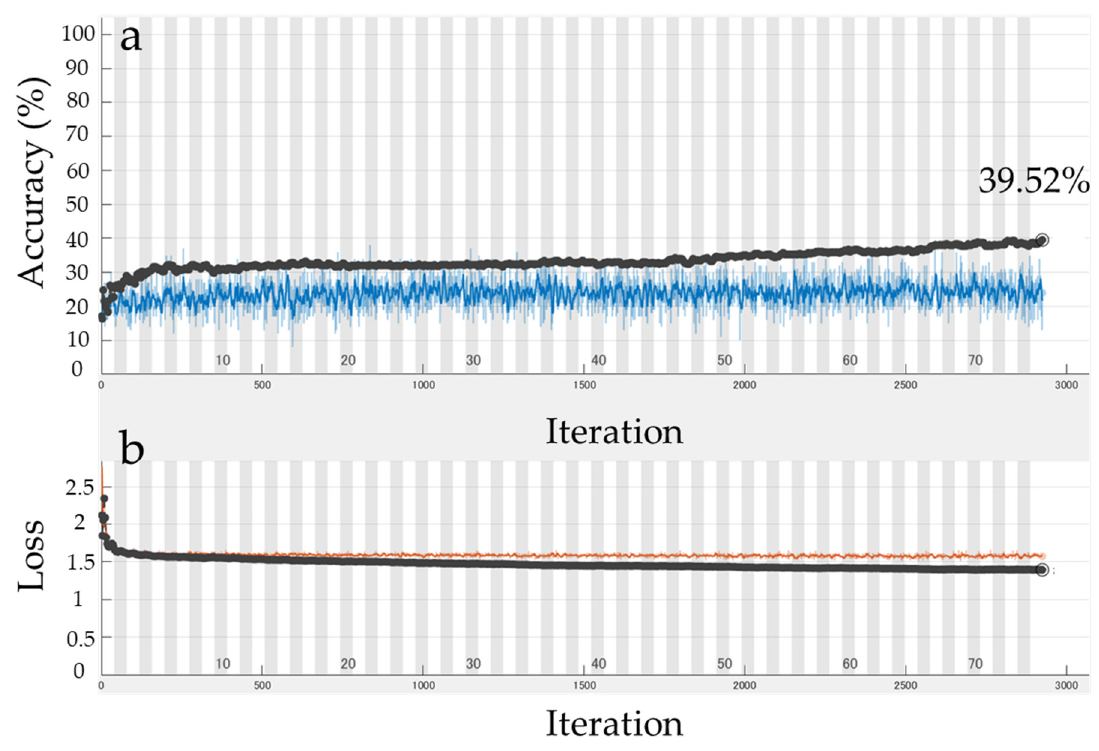
Figure 10. ( a ) Learning curve of the RGB images using deep learning. (The horizontal axis shows the iteration and the vertical axis shows the accuracy of classification. The blue line shows the accuracy for the learning data set and the black dots represent the accuracy for the verification data set.) ( b ) The loss function of RGB images using deep learning. (The horizontal axis shows the iteration and the vertical axis shows the loss of classification. The orange line shows the loss for the learning data set and the black dots represent the loss for the verification data set.). Table 3. Result of deep learning for RGB images for the learning data.